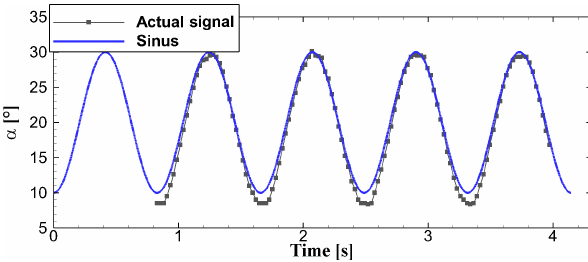
Figure 10. Comparison of the time series of the idealized sinusoidal angle of attack to the exact signals in the experimental campaign for the S801 airfoil, k = 0 . 073, α = 20 ◦ and (cid:49)α = 10 ◦